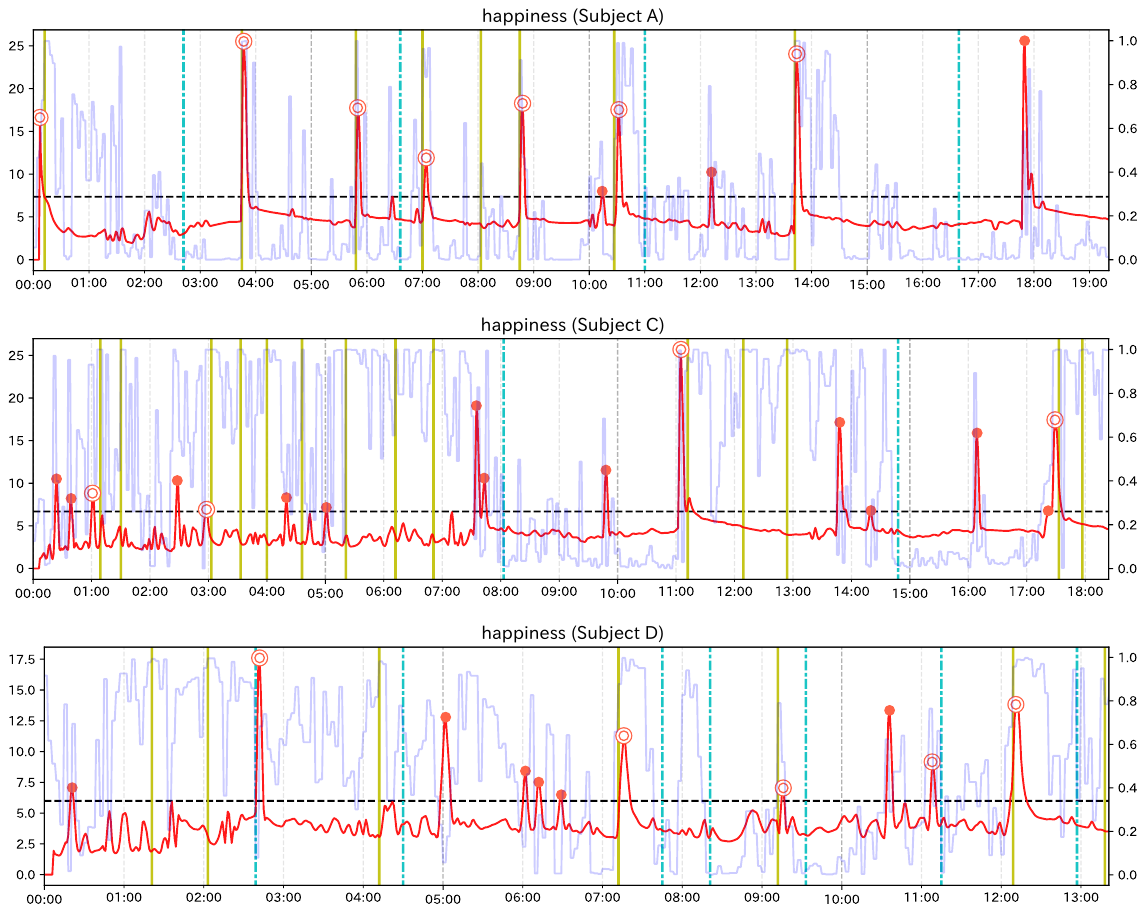
Figure 13. Graphs of the change score for FET’s “happiness” value (Subject group